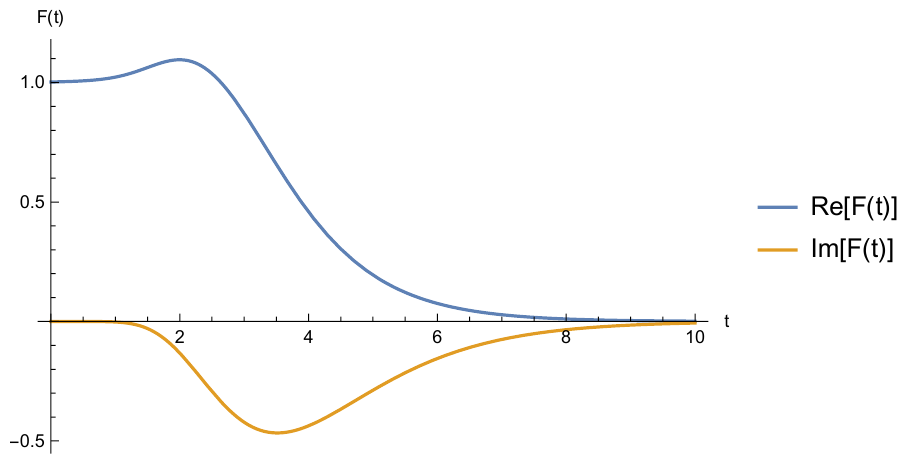
Figure 5 . The out-of-time-order correlator h V L (0) W R ( t ) V R (0) W R ( t ) i for j g ( t = 0) j = 10 ; ‘ =